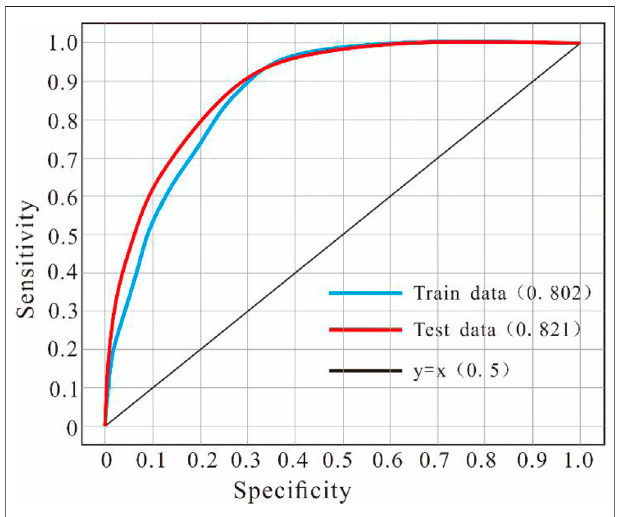
FIGURE 4 | Analysis of the ROC curves of the train and test data.